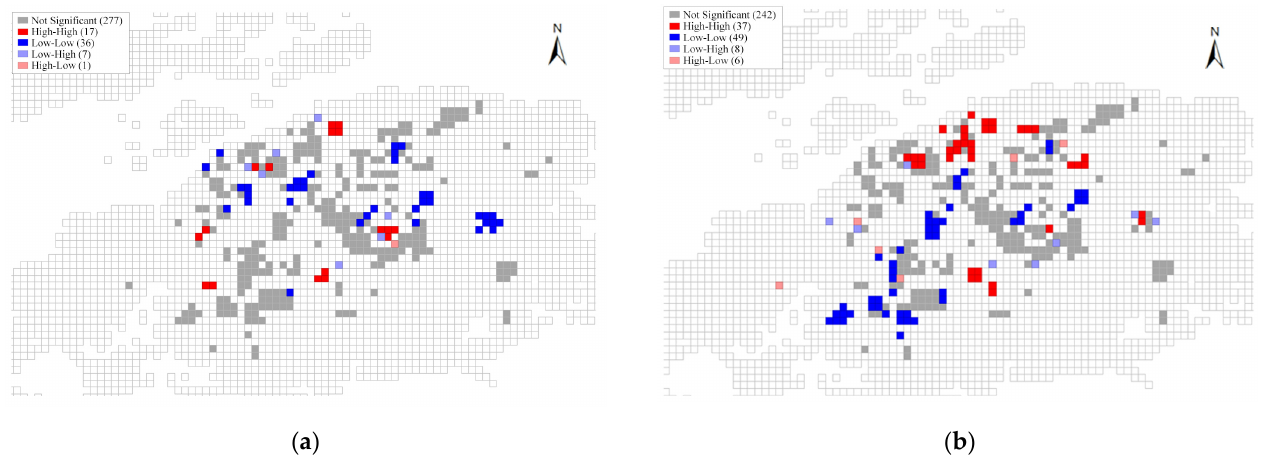
Figure 10. LISA cluster map of the EUI of sample buildings. ( a ) Annual electricity EUI; ( b ) annual heating EUI [41].